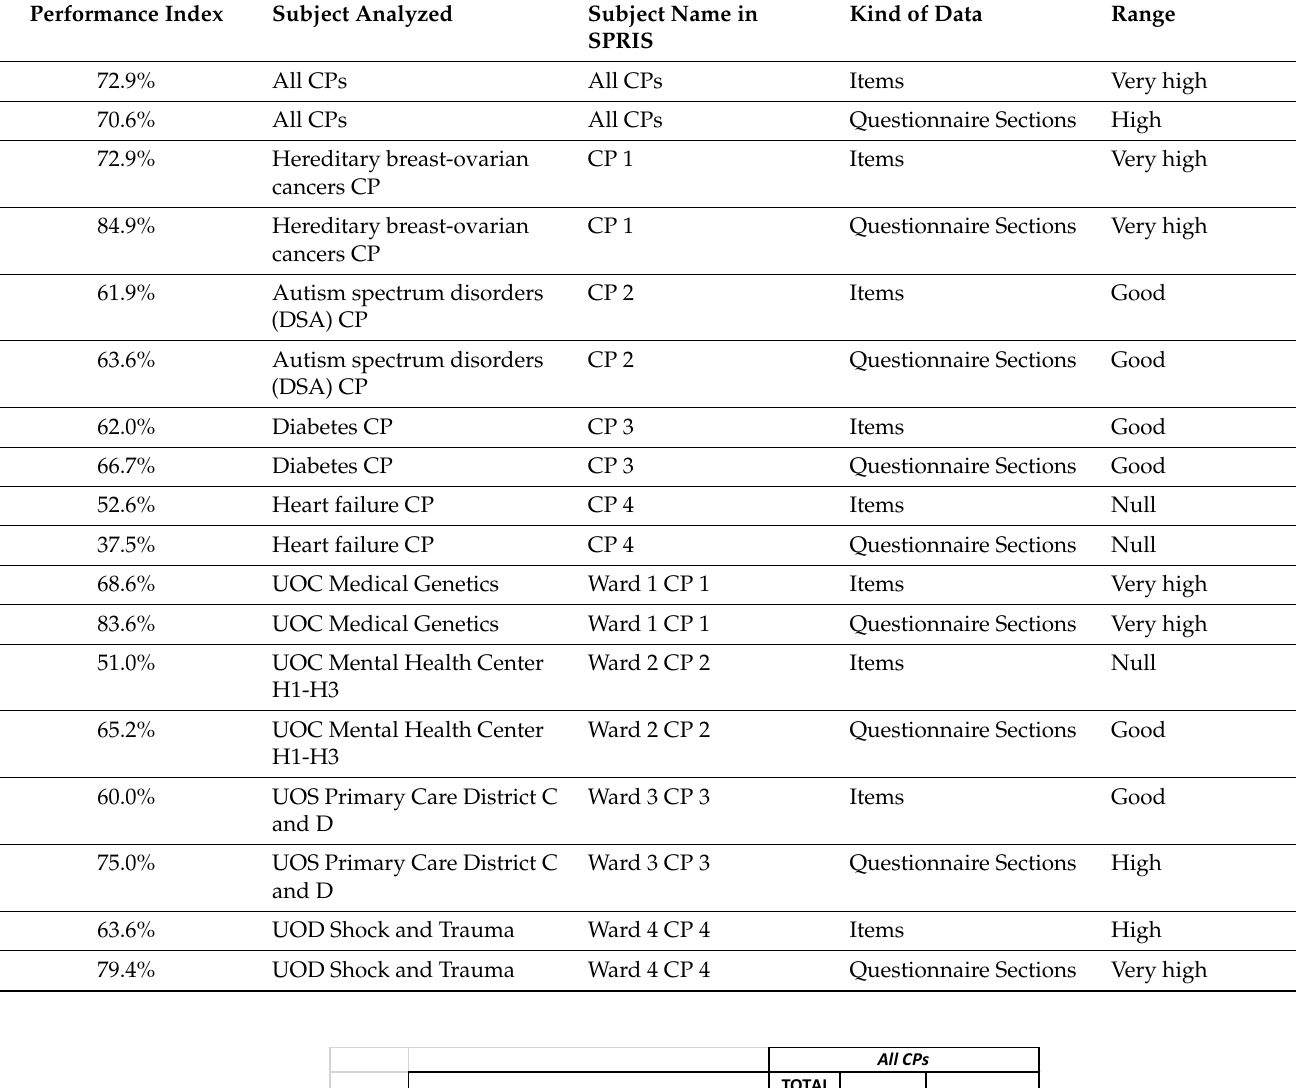
Table 3. Summary of the results regarding the performance indexes and their corresponding ranges.